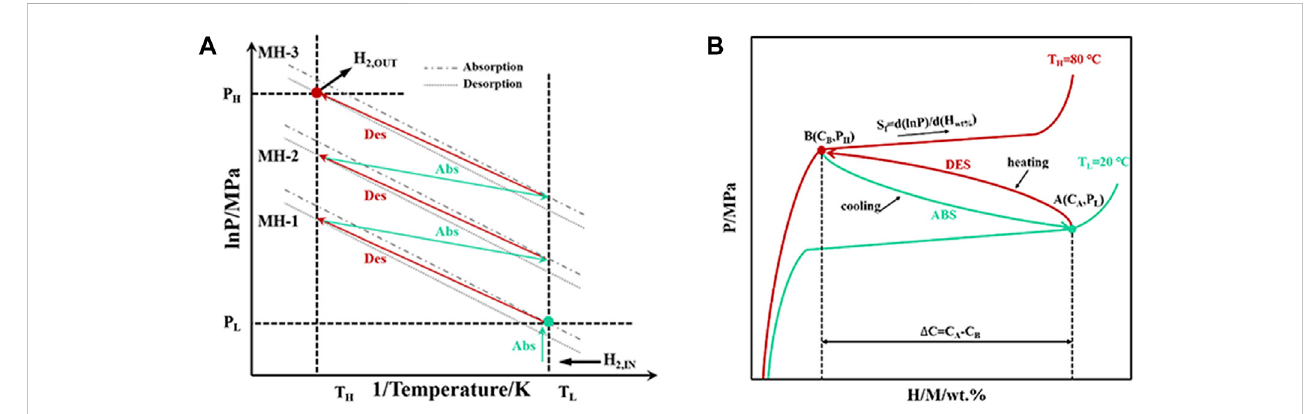
FIGURE 7 Schematic diagram of a three-stage hydrogen compressor (A) ; and working principle of hydrogen compression materials (B) (Peng et al.,